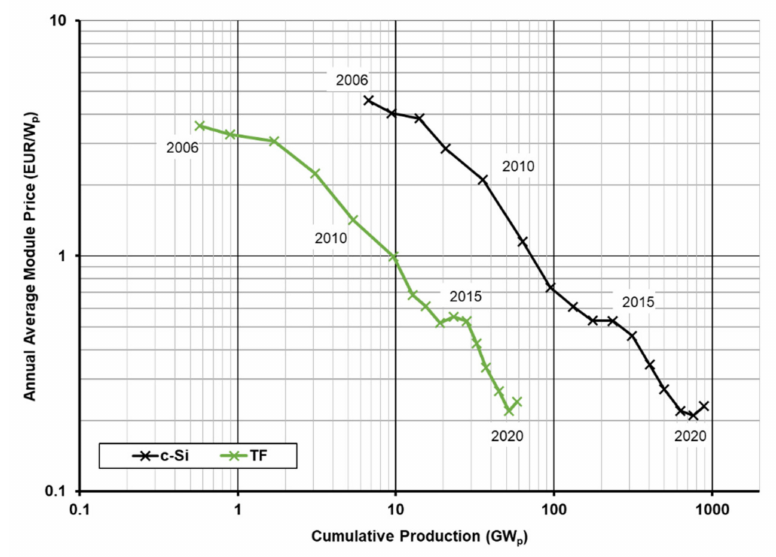
Figure 4. PV modules technological learning curve for crystalline silicon (c-Si) and thin film (TF) technologies.